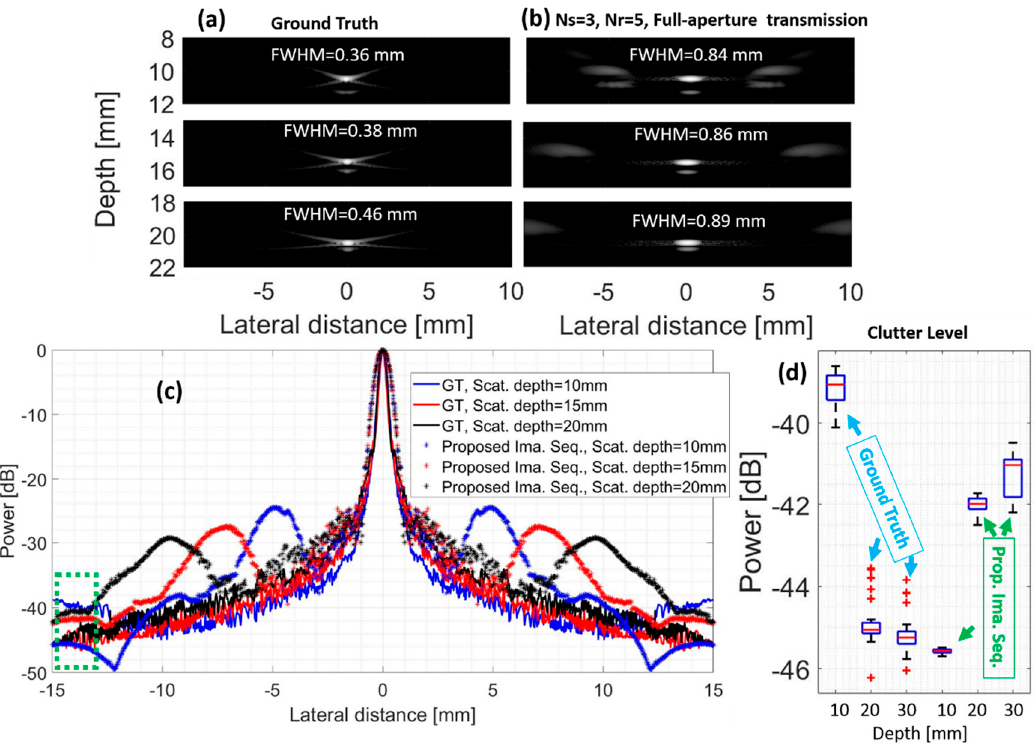
Figure 8. The reconstructed images using ( a ) the column-by-column (CBC) imaging sequence (ground truth—GT) and ( b ) the proposed imaging sequence (full-aperture transmission, Nr = 5 and Ns = 3), along with ( c ) their corresponding lateral variations. The AW is applied on the GT to have a fair comparison. ( d ) The clutter level using the green rectangular region in (c).